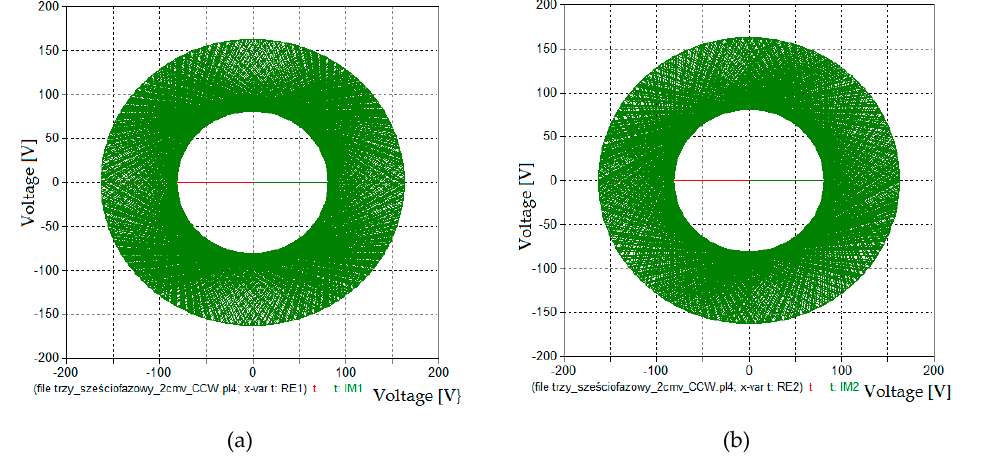
Figure 8. Trajectories of the output voltage phases 1,3,5 ( a ), trajectories of the output voltage phases 2,4,6 ( b ), synthesized in the MC controlled by the use of the CCW rotating space vectors, for six-phase load with two star points and output frequency of 30 Hz.